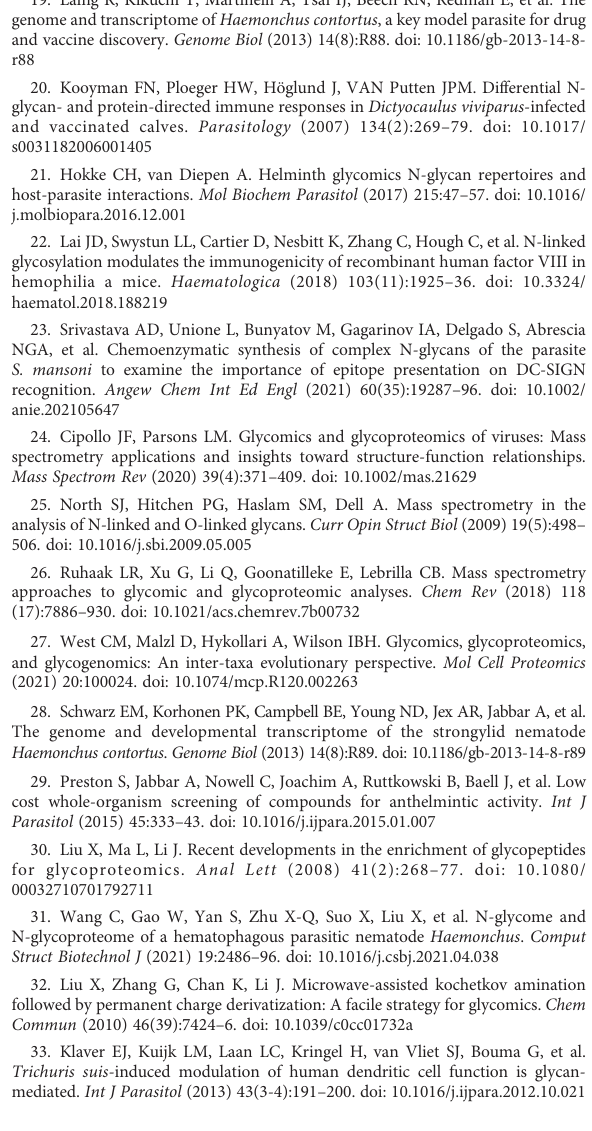
SUPPLEMENTARY TABLE 5 List of aminopeptidases and their N-glycosylation sites identi fi ed in native H11 from Haemonchus